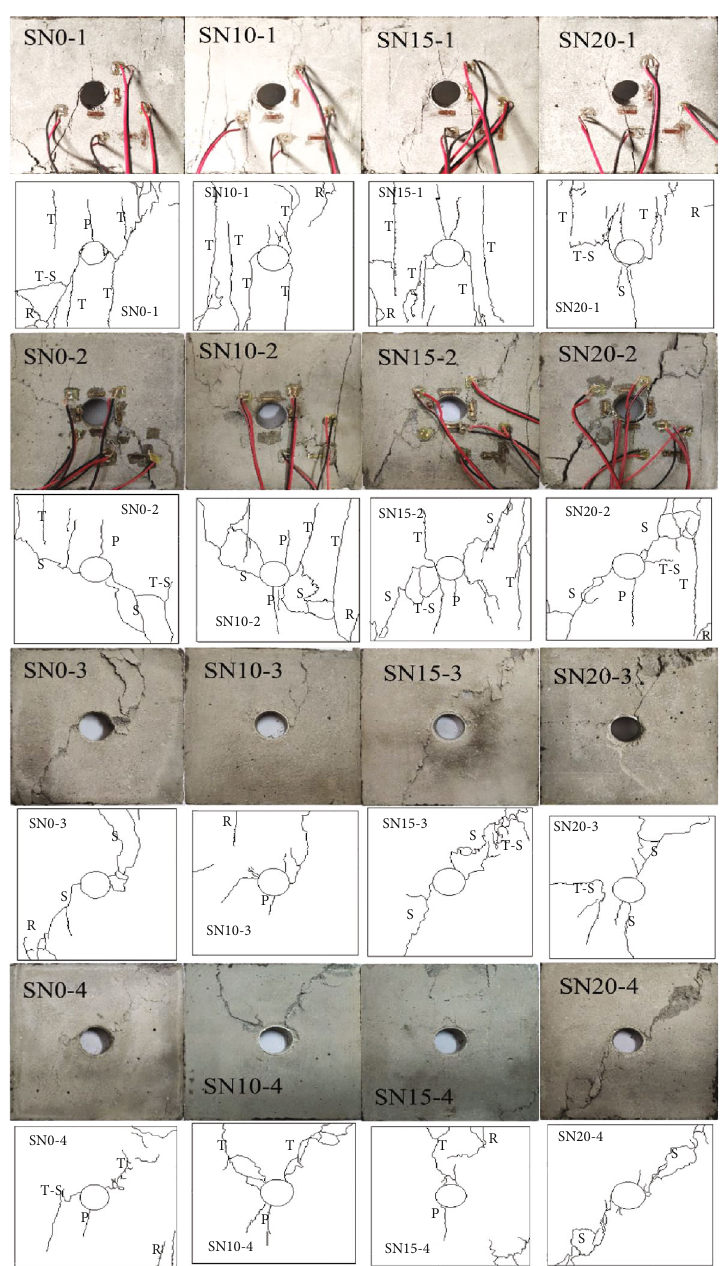
Figure 7: Failure morphology and schematic diagram of all specimens (T: tensile crack, S: shear crack, T-S: tensile-shear crack R: remote crack, and P: primary